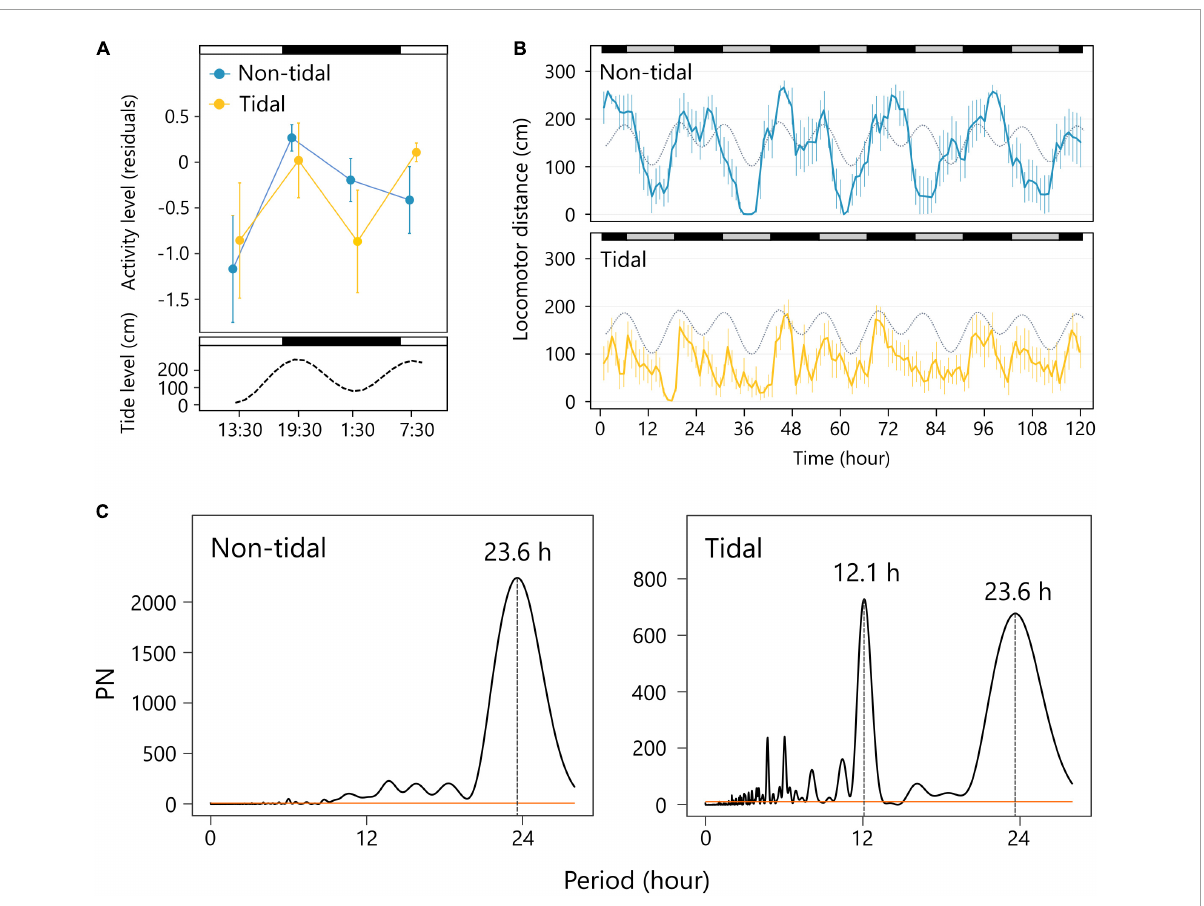
FIGURE1 Activity patterns of non-tidal and tidal individuals. (A) Daily changes in the activity level (residuals of the regression of locomotion distance on the time after the onset of the experiment) in the field. Error bars depict the standard error of the mean (SEM). The non-tidal and tidal populations in each observation time are shown in blue and yellow, respectively. The white and black bars represent light and dark conditions, respectively. The lower panel represents a tidal level. (B) Locomotor distance of the non-tidal and tidal population for 5 days under the constant dark (DD) condition in the laboratory. Error bars are SEM. Subjective day and night are shown as gray and black bars above. The tide level of the natural environment is shown as a gray dotted line. (C) Lomb–Scargle periodogram analysis. Peaks in the circatidal and circadian range are